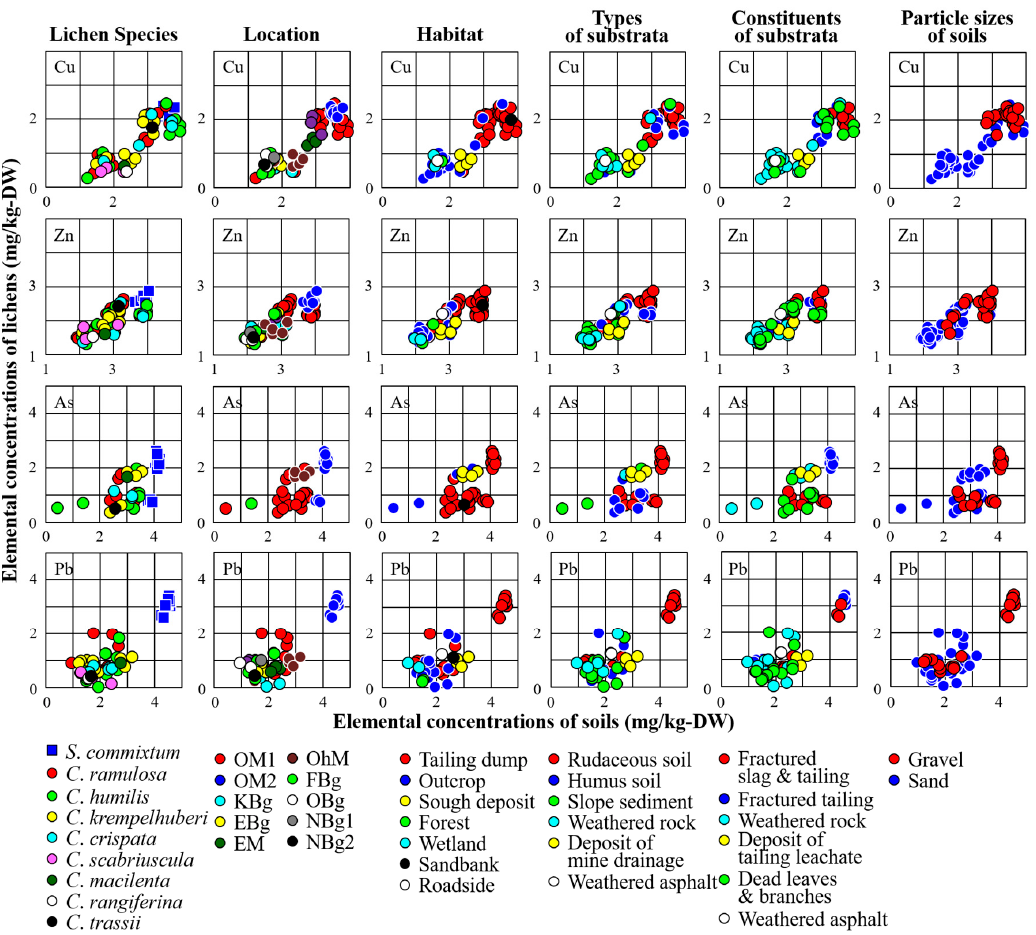
Figure 5. Scatterplots of Cu, Zn, As, and Pb concentrations in lichens and the corresponding substrata, separated by lichen species, location, habitat, types of substrata, constituents of substrata, and particle sizes of soils using different colors.